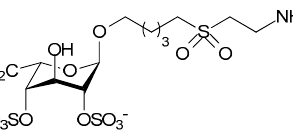
Figure 13. The unnatural synthetic monosaccharide, Di-S-IdoA containing two axial sulfate